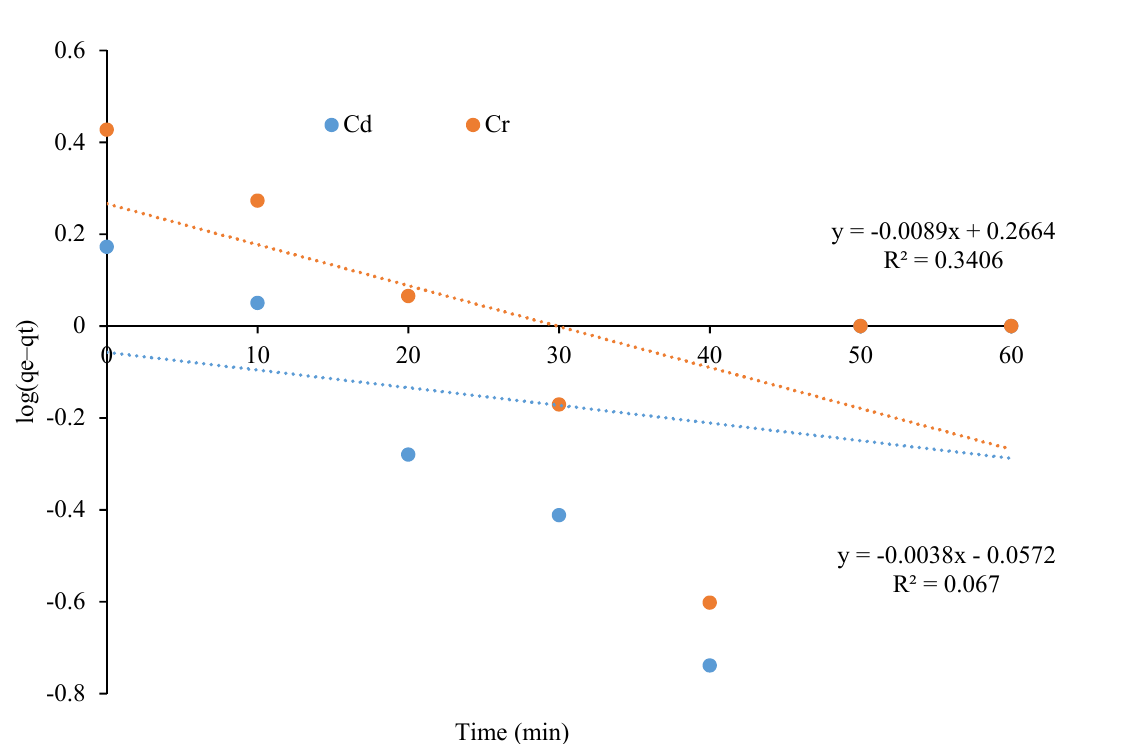
Figure 9. Pseudo-first-order kinetic plot of metal adsorption on the CeO 2 /corncob nanocomposite.